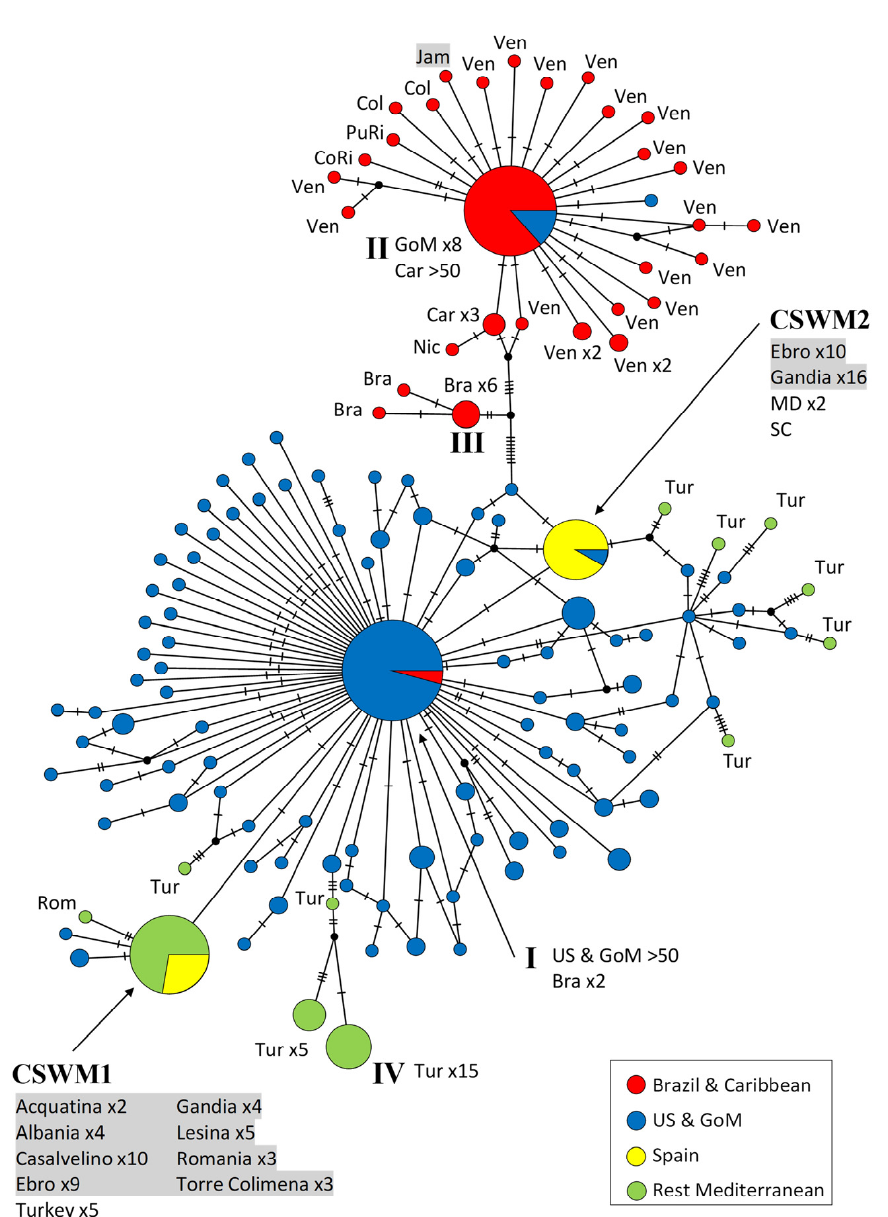
Figure 2. Maximum parsimony network showing genetic distances among 412 sequences of Callinectes sapidus corresponding to the ‘Folmer region’ of COI (644 bp; 71 current study, 341 GenBank), constructed with TCS (Popart vers. 1.7). Each circle represents one haplotype. Diameters of the circles correspond to the frequencies of the respective haplotypes. The numbers of dashes display mutational steps (each dash stands for one single nucleotide mutation). Small black circles represent hypothetical (missing) haplotypes. Sample locations are represented by colors, with the North American lineage in blue, South American and Caribbean lineages in red, Spanish ones in yellow, and the remaining Mediterranean Sea in green. Self-generated sequences are shown as grey fields. Abbreviations: Bra = Brazil, Car = Caribbean Sea, Col = Colombia, CoRi = Costa Rica, Jam = Jamaica, GoM = Gulf of Mexico, Mex = Mexico, Nic = Nicaragua, PuRi = Puerto Rico, Rom = Romania, Ven = Venezuela; MD = Maryland, SC = South Carolina. Numbered haplotypes: I = most common North American haplotype; II = most common Caribbean haplotype; III = most common Brazilian haplotype; IV = most common haplotype recorded from Turkey.